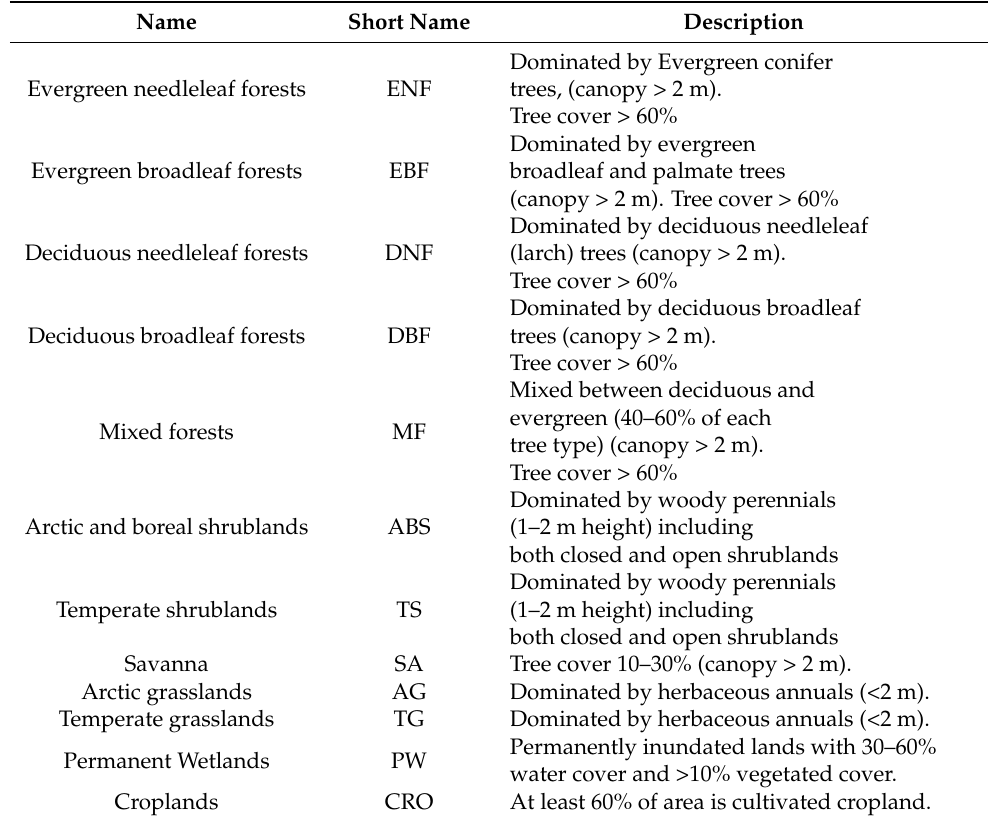
Table 1. Definitions of the 12 terrestrial biomes were developed by [26]. Grass- and shrublands were further divided in Arctic/boreal and temperate groups according to